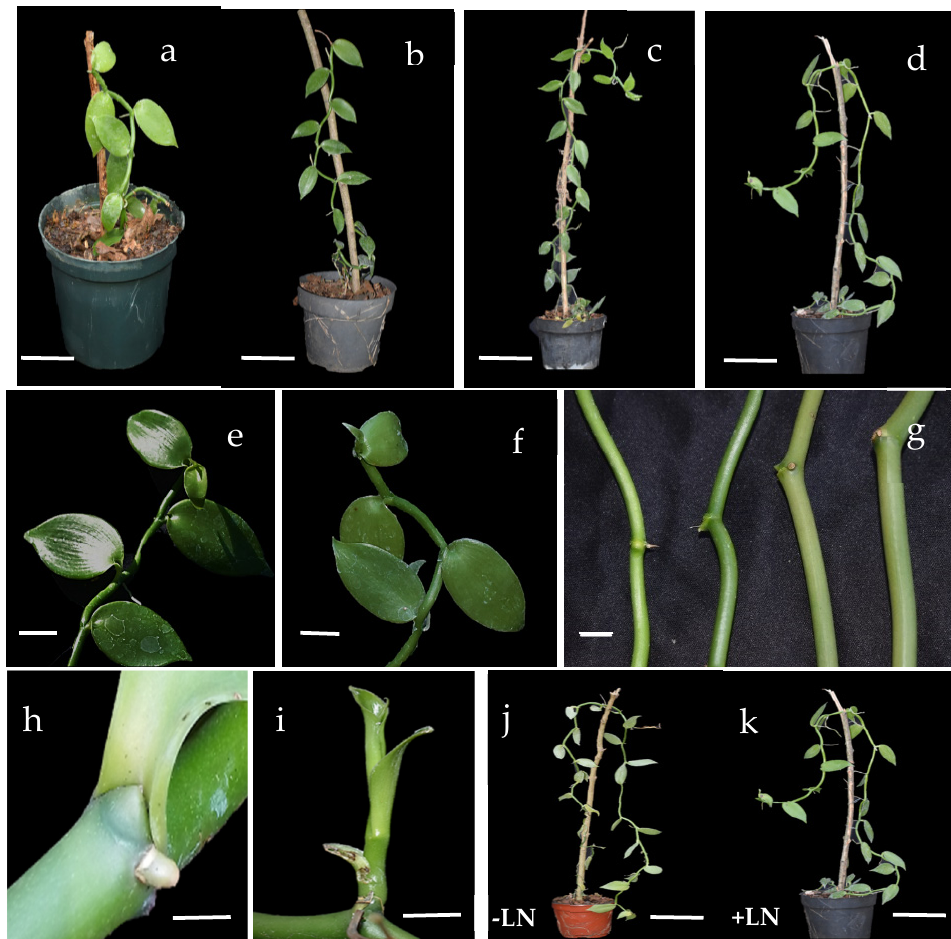
Figure 1. Vegetative growth of greenhouse-cultured plants of V. planifolia . Cryo-derived regenerants produced using the D-Cp method and grown for ( a ) 3 months (bar 5 cm), ( b ) 6 months (bar 5 cm), ( c ) 9 months (bar 10 cm), and ( d ) 12 months (bar 10 cm) in the greenhouse. Leaves ( e ) from in vitro- control (bar 2 cm) and ( f ) from D-Cp method (bar 2 cm) regenerants. Vanilla stems ( g ) from in vitro- control, D-V, V-Cp, and D-Cp regenerants. ( h ) Axillary bud (bar 1 cm), ( i ) newly developed shoot from D-Cp method regenerants (bar 1 cm). ( j ) Plant from in vitro-control (not subjected to cryopreservation, -LN) (bar 10 cm) and ( k ) cryo-derived plants (+LN) using D-Cp method (bar 10 cm)—both grown in the greenhouse for 12 months.